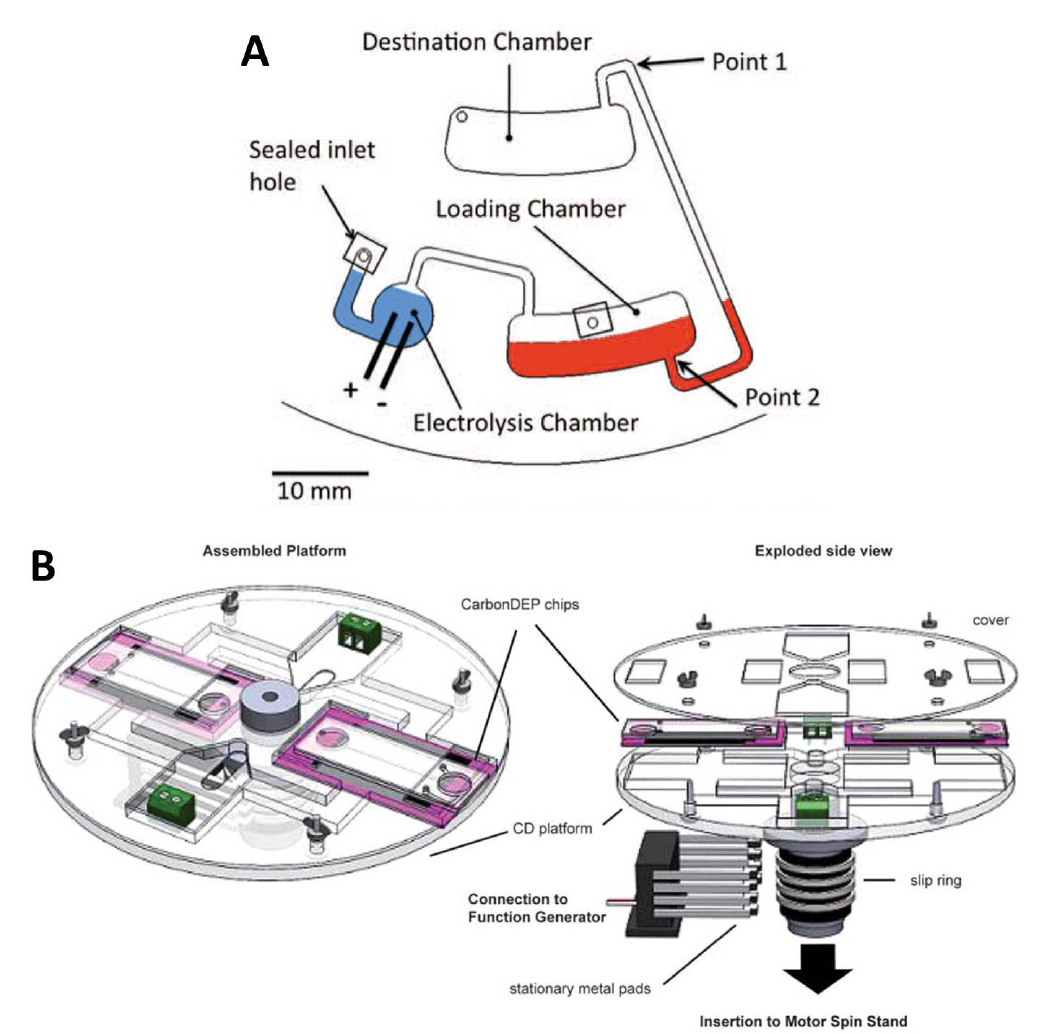
Figure 10. Electrochemistry implemented on CD-based systems. ( A ) Fluidic handling through electrolysis-generated pneumatic pressure [76]. Electrolyte and sample are loaded and localized at the bottom of their respective chambers as a result of spinning the disc. Electrical potential applied to the electrodes in the electrolysis chamber causes the sample to rise along the radial chamber to Point 1, completely transferring the sample to the destination chamber as long as electrical potential is applied. Reproduced in part by permission of The Electrochemical Society. ( B ) Carbon electrode dielectrophoresis (DEP) for trapping particles of interest. The set-up consists of a CD platform mechanically connected to a motor through a custom-made spin chuck and slip ring configuration for electrically connecting a function generator to the spinning disc. The CD houses an electrical circuit to interface the signal from the function generator to the DEP chips that are positioned in slots on the CD device. The chips contain DEP electrodes and microfluidic networks, providing a modular experimental set-up. Reproduced from [140] with permission of The Royal Society of